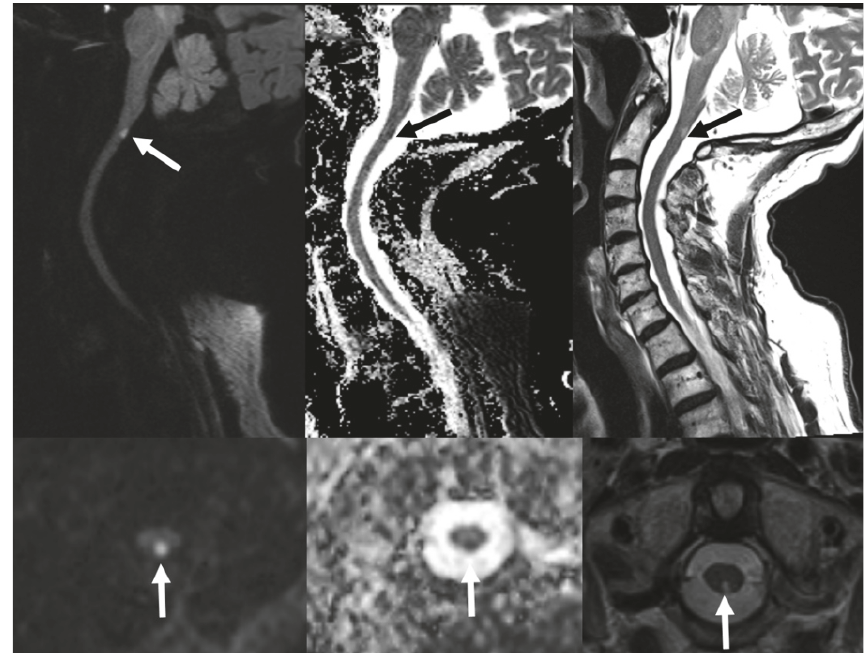
Figure 2: MRI Cervical spine axial and sagittal planes, (left panel) showing hyperintensity on diffusion weighted sequence, hypointensity on ADC sequence (middle panel), and hyperintensity on T2 sequence (right panel) indicating acute spinal cord infarction